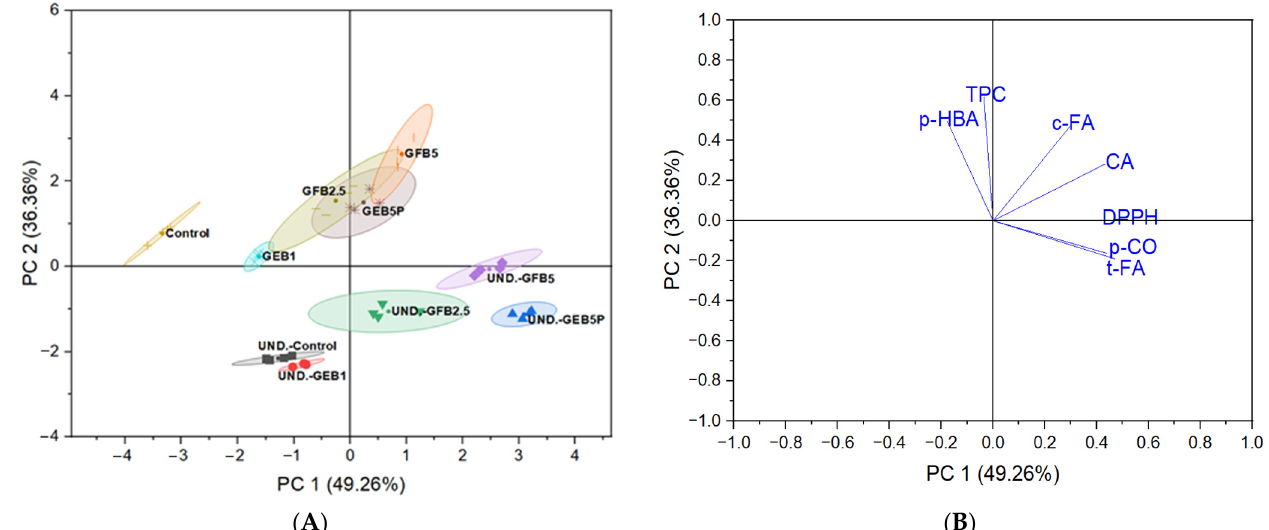
Figure 3. Principal component analysis score plot ( A ) and loading plot ( B ) describing the relationships among different extractable biochemical parameters of the undigested and digested breads. Control: wheat bread with no added bioprocessed flour; GEB1: wheat bread enriched with 1% “germinated + enzymatic treated” spelt flour; GEB5P: wheat bread enriched with 5% pasteurized “germinated + enzymatic treated” spelt flour; GFB2.5: wheat bread enriched with 2.5% “germinated + fermented” spelt flour; GFB5: wheat bread enriched with 5% “germinated + fermented” spelt flour. UND.: undigested. Biochemical parameters: p -CO: p -coumaric acid; t-FA: trans -ferulic acid; c-FA: cis -ferulic acid; CA: caffeic acid; p -HBA: p -hydroxybenzoic acid; TPC: total phenolic content; DPPH: DPPH